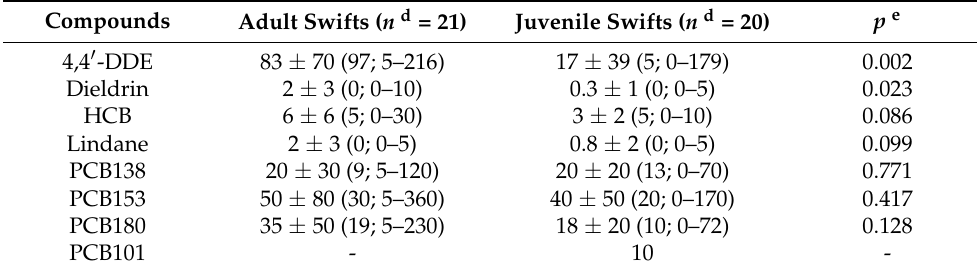
Table 3. Different concentrations of organochlorine pesticides and polychlorinated biphenyls between pooled organ samples of adult and juvenile common swifts detected in 2016–2018 in µ g/kg ww: Mean ± SD a (Median; Xmin b –Xmax c